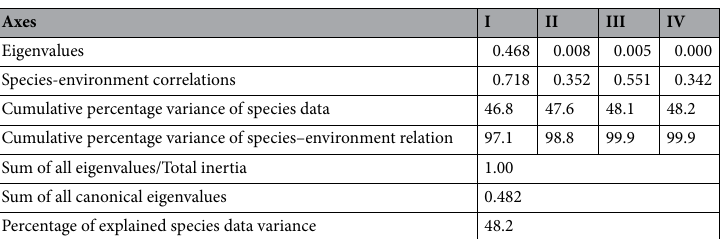
Table 3. Summary of redundancy analysis (RDA) of samples collected at Carex buekii sites in Poland, Slovakia, and Hungary.